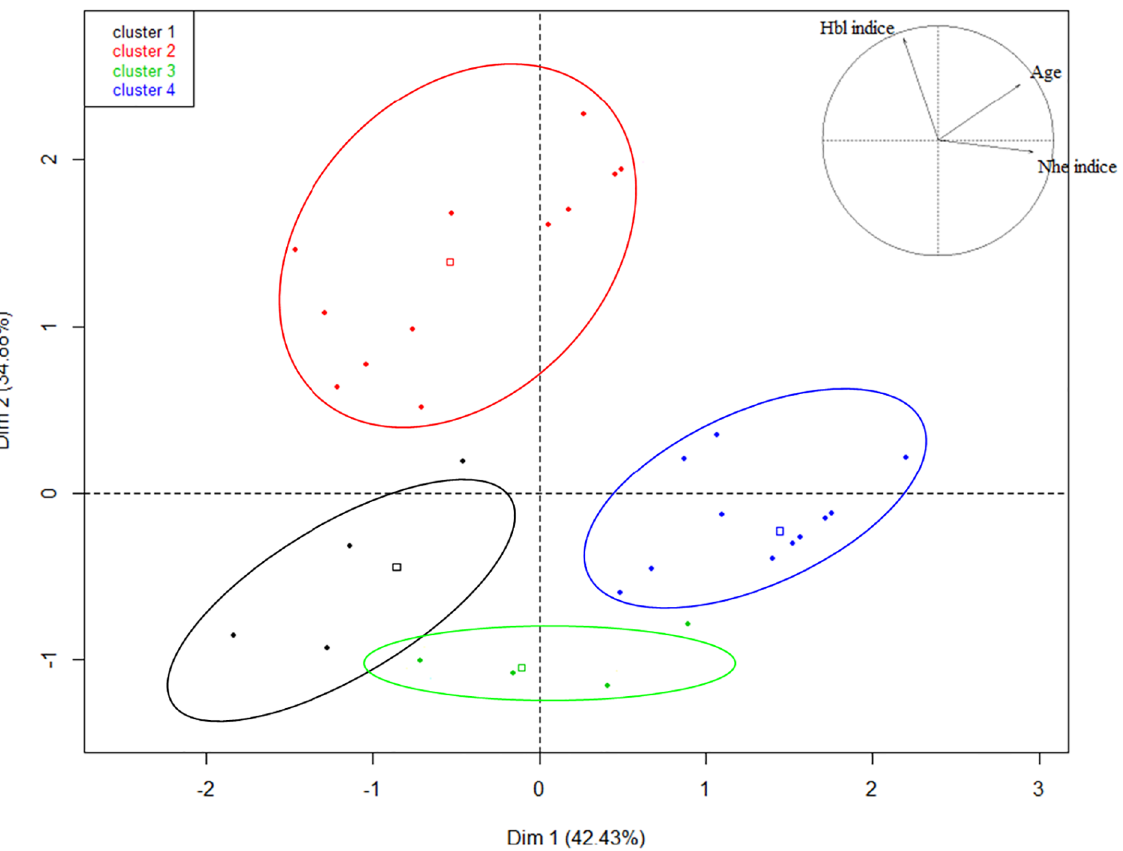
Fig 3. Correlation clusters of the quantitative variables characterizing each B . cereus strain isolated from patients. The percentages of variation explained by the principal components (PC1 and PC2) are indicated in brackets. The factors involved in PC1 (Dim1: age of patients and NHE indice) and PC2 (Dim2: HBL indice) are indicated in the variable factor map at the top right of the figure. The strains located inside a colored circle belong to the same cluster, as determined by the hierarchical cluster analysis performed after PCA. Each dot corresponds to a strain. The squares represent the representative value for the